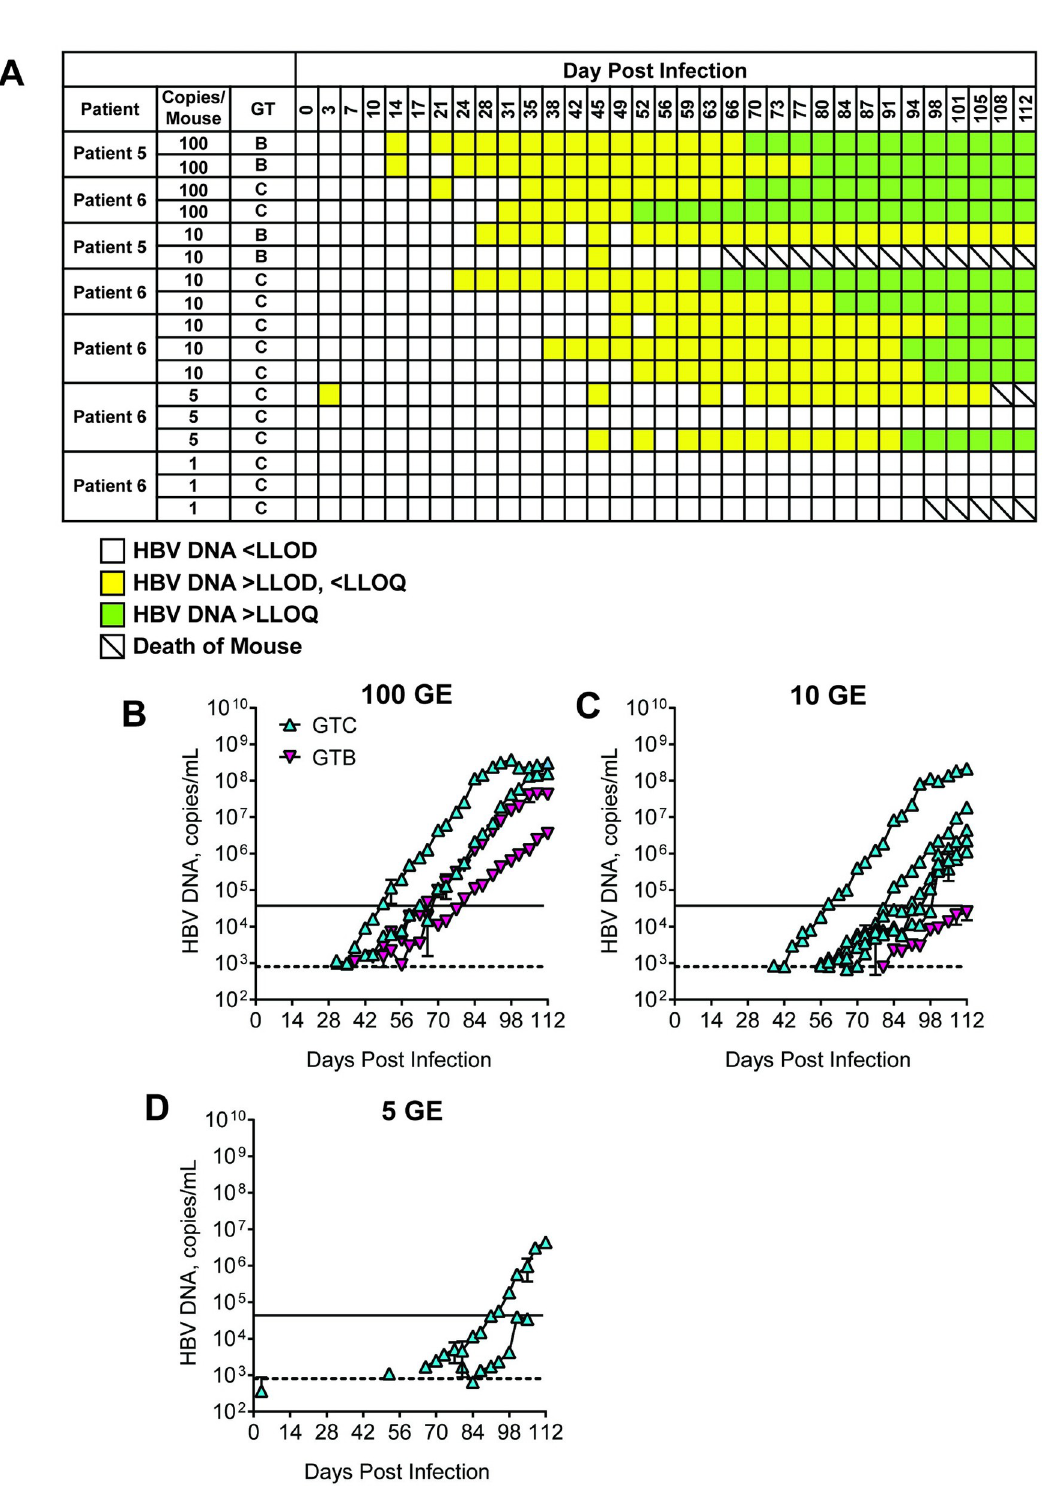
Fig 2. Establishment of the lower LLOD in human liver chimeric mice. Mice were infected with 0.1 mL of sera from patients chronically infected with HBV diluted to contain a total of 100 copies (n = 4), 10 copies (n = 7), and 5 copies (n = 3). a, Summary of PCR results over time. Blank squares indicate HBV DNA values were < LLOD. Yellow squares indicate HBV DNA values were > LLOD but < LLOQ. Green squares indicate PCR was positive and HBV DNA values were > LLOQ. b-d Mean infectivity of mice (n = 2) infected with of 100, 10, and 5 copies of HBV DNA in the uPA-SCID model. HBV DNA was measured by qRT-PCR and